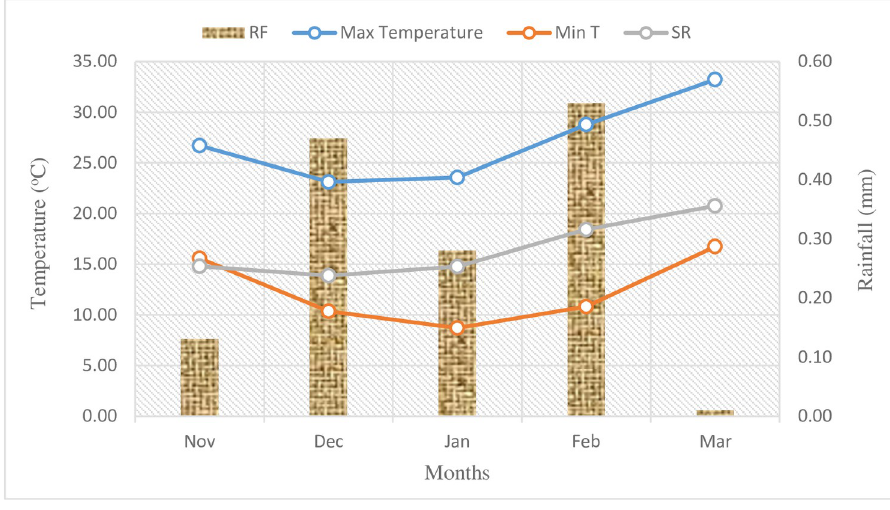
Fig 1. Monthly average rainfall, maximum and minimum temperature, solar radiation during crop growing season in Bhopal, India. (Max T: Maximum temperature (˚C); Min T: Minimum temperature (˚C); SR: Solar Radiation